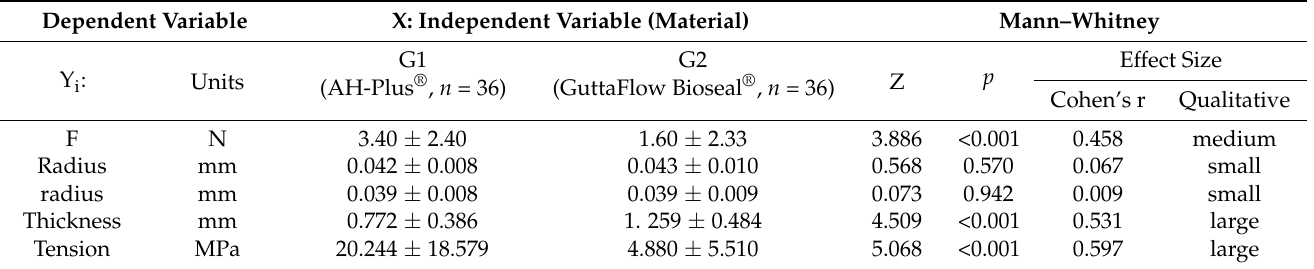
Table 4. Means and standard deviations by group and Mann–Whitney results regarding the effect of the endodontic sealer.